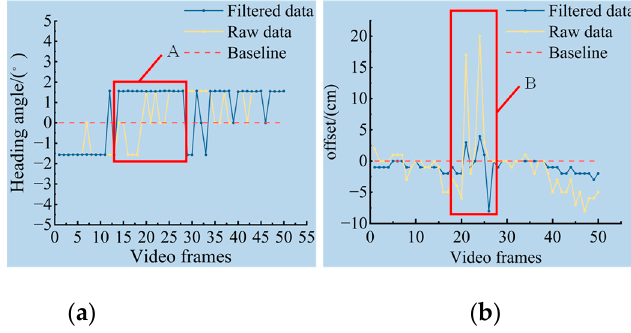
Figure 18. ( a ) Diagram of heading angle; ( b ) Diagram of offset.